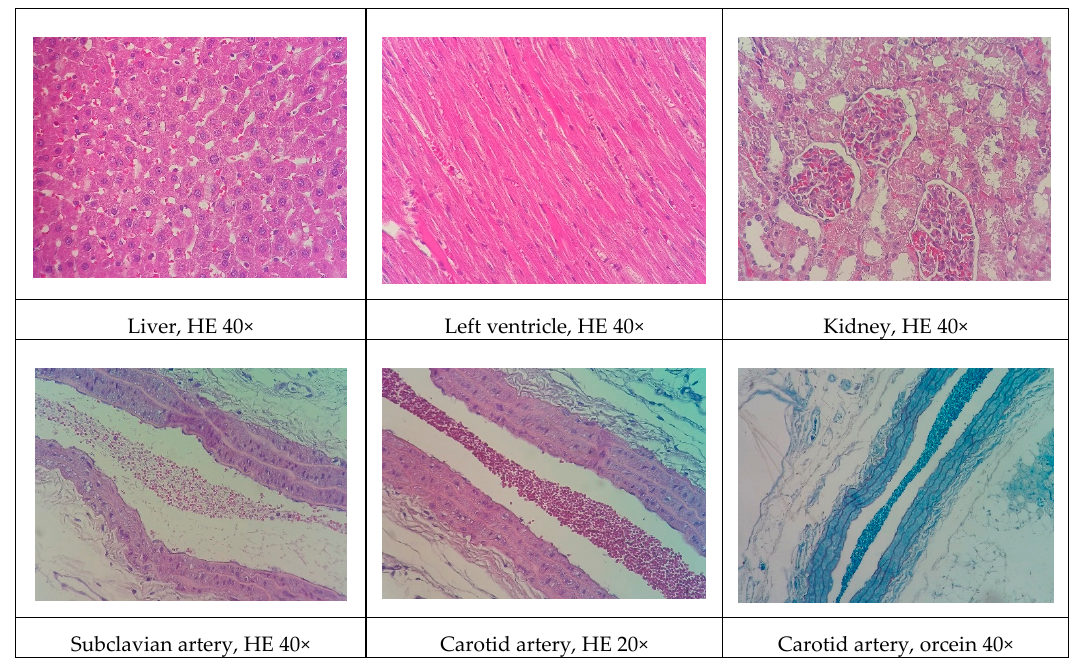
Figure 5. Representative cross-sections of the liver, left ventricle, kidney, and subclavian and carotid arteries in the control group. HE, hematoxylin-eosin staining.